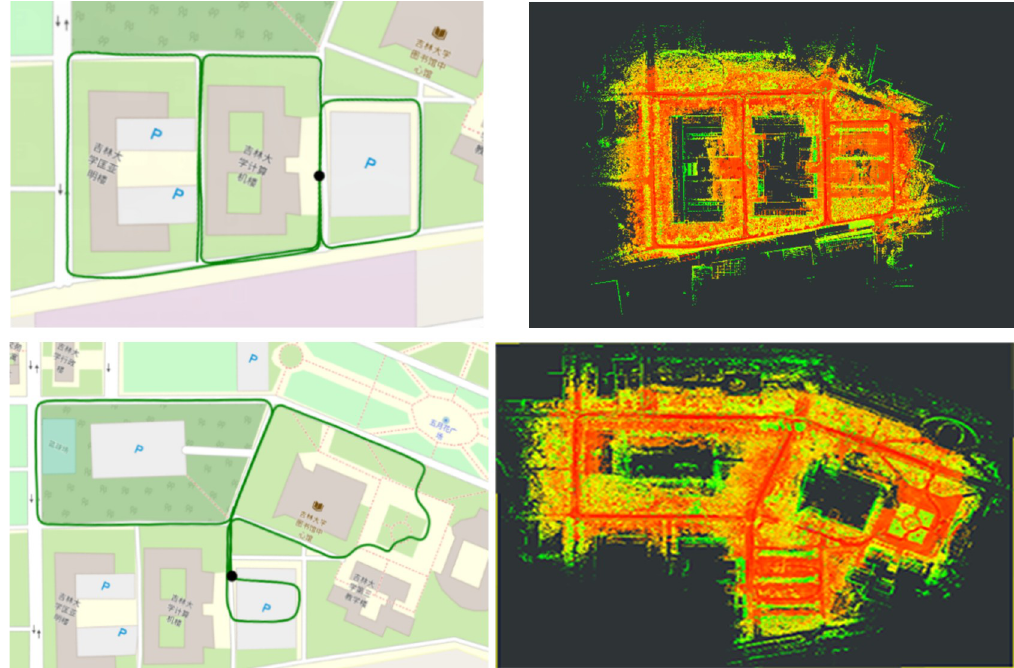
Fig 12. USGS national map imagery and mapping results of LIO-CSI. The green track in USGS National Map imagery is the actual trajectory of Tiguan Volkswagen movement.